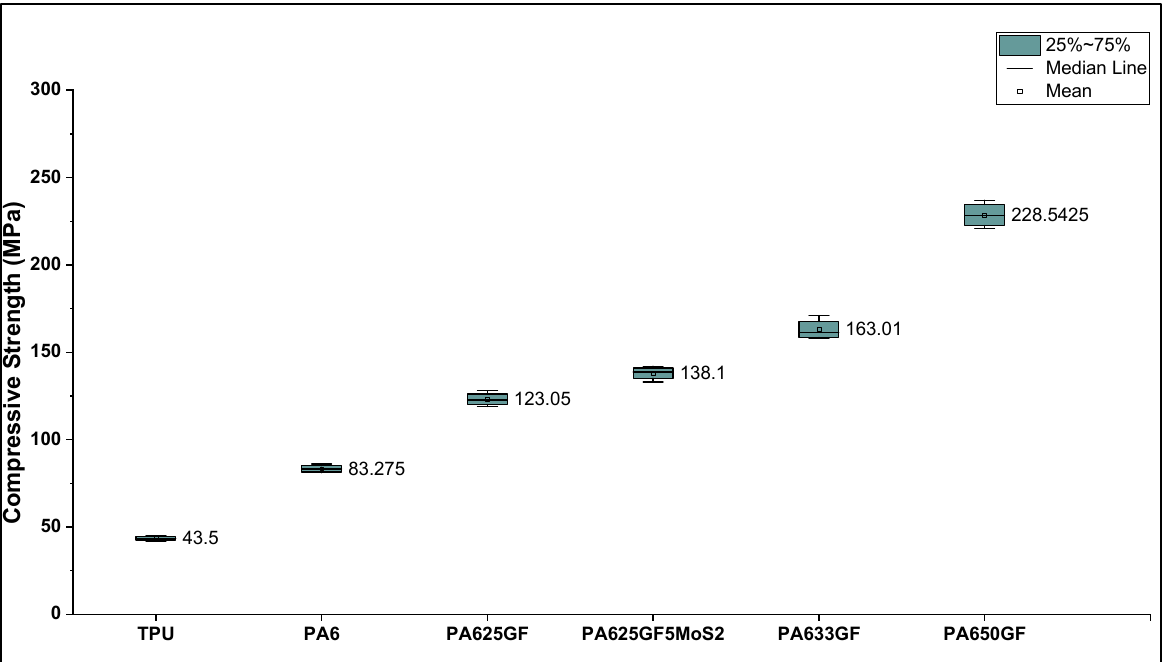
Figure 6. Compressive strength for polymers and their fibre-reinforced variations .